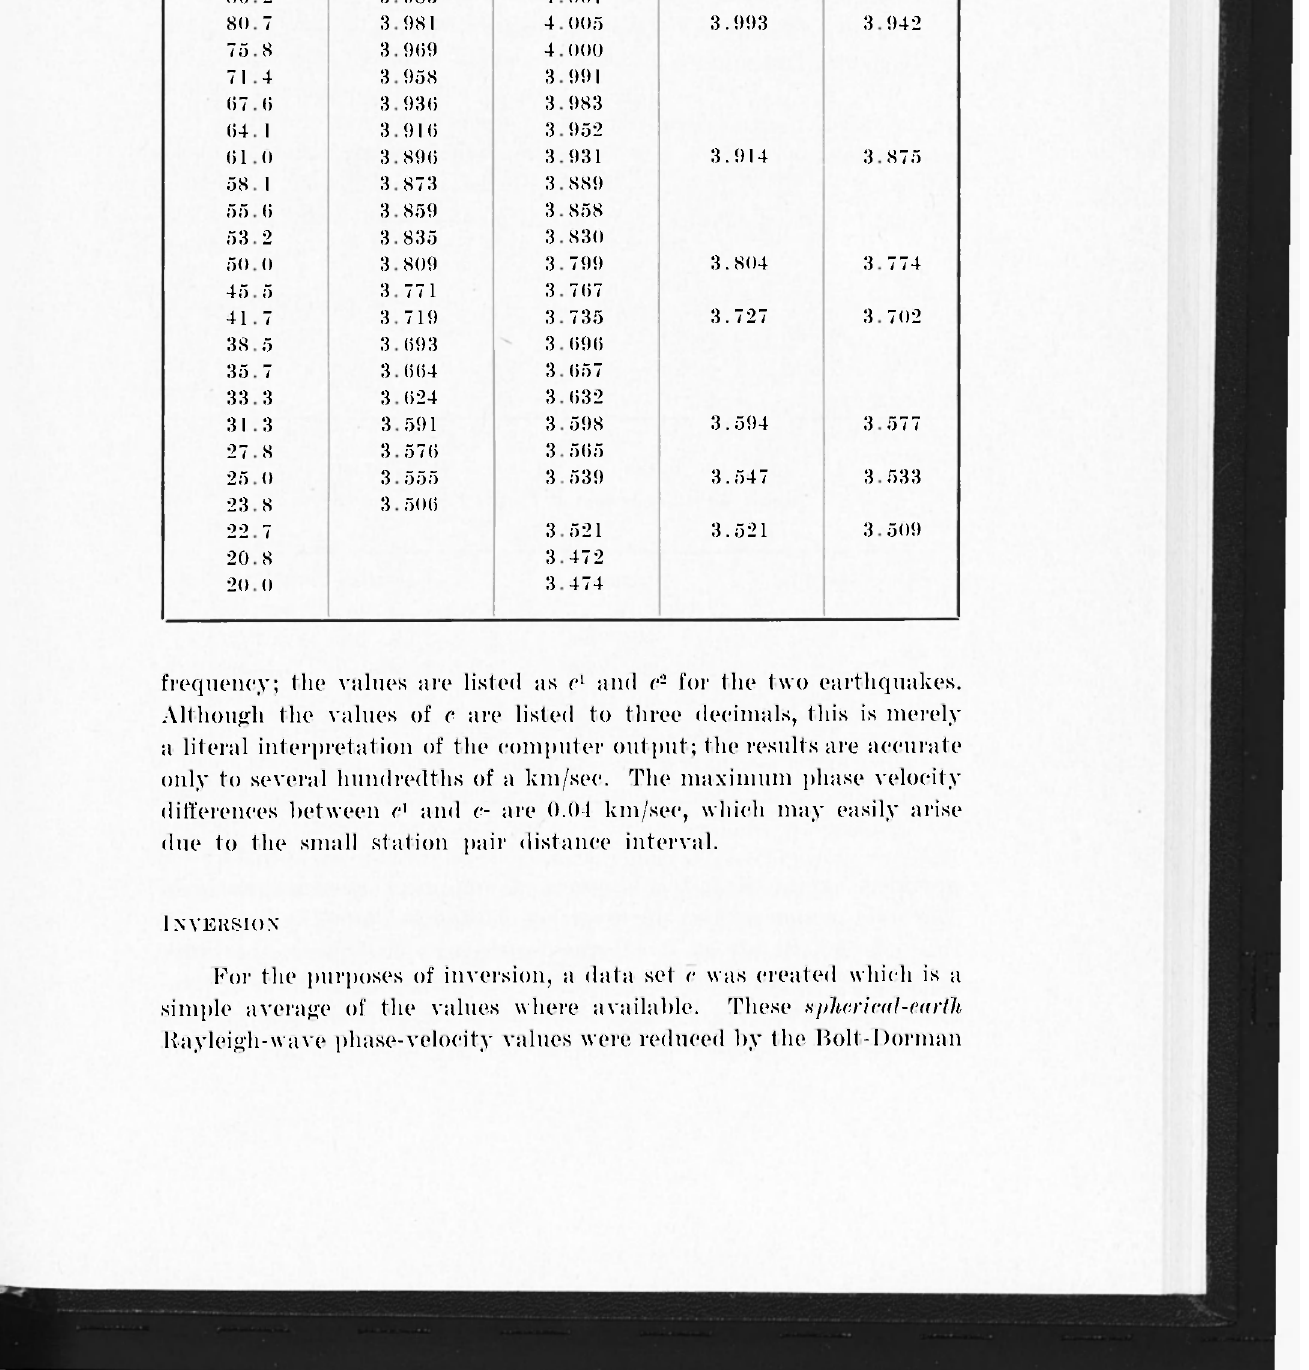
KAYLEIGII WAVE PHASE VELOCITIES AND UPPER MANTLE